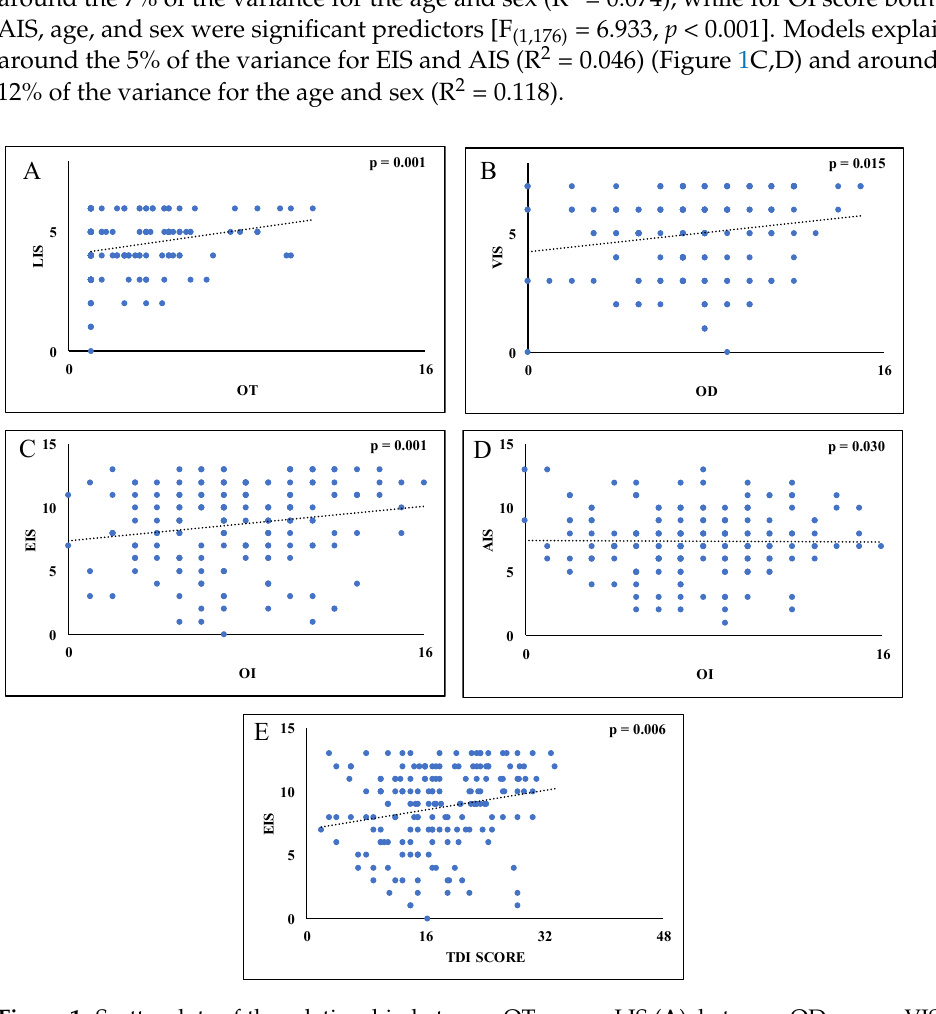
Figure 1. Scatterplots of the relationship between OT versus LIS ( A ), between OD versus VIS ( B ), between OI versus EIS ( C ), between OI versus AIS ( D ), and finally between TDI score versus EIS ( E ). Finally, multivariate linear regression analysis showed that using TDI score as a dependent variable only EIS, age and sex were significant predictors [F (1,176) = 7.782, p < 0.006]. The model explained around the 4% of the variance for the EIS (R 2 = 0.037) (Figure